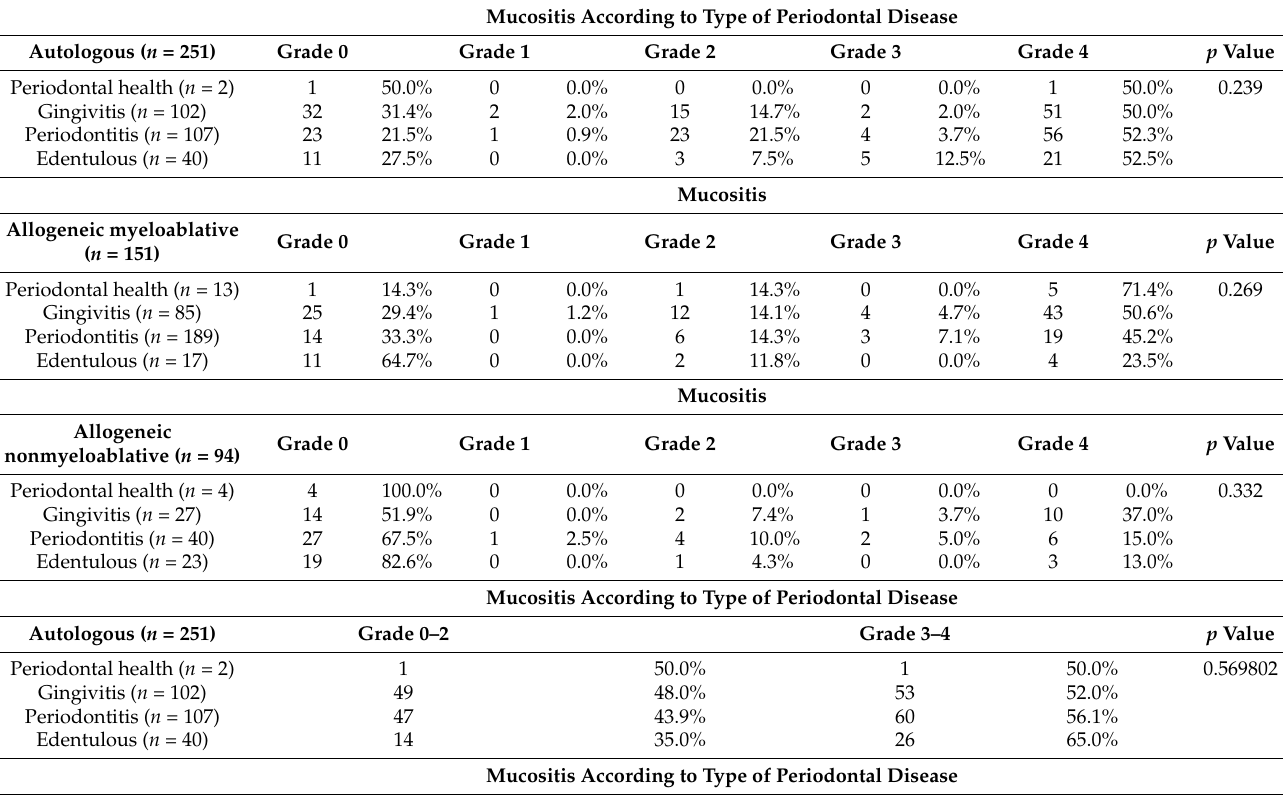
Table 5. Oral mucositis in SCT subgroups according to type of periodontal disease.